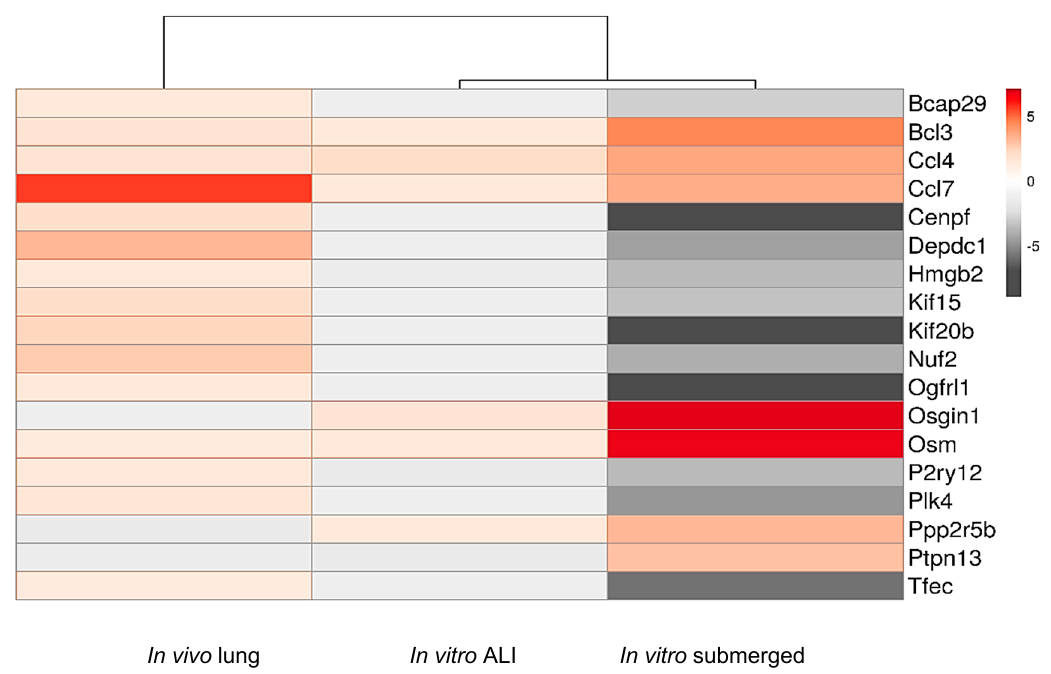
Figure 5. Heatmap of common dysregulated genes, fold changes are represented by a color scale ( p -value < 0.05).